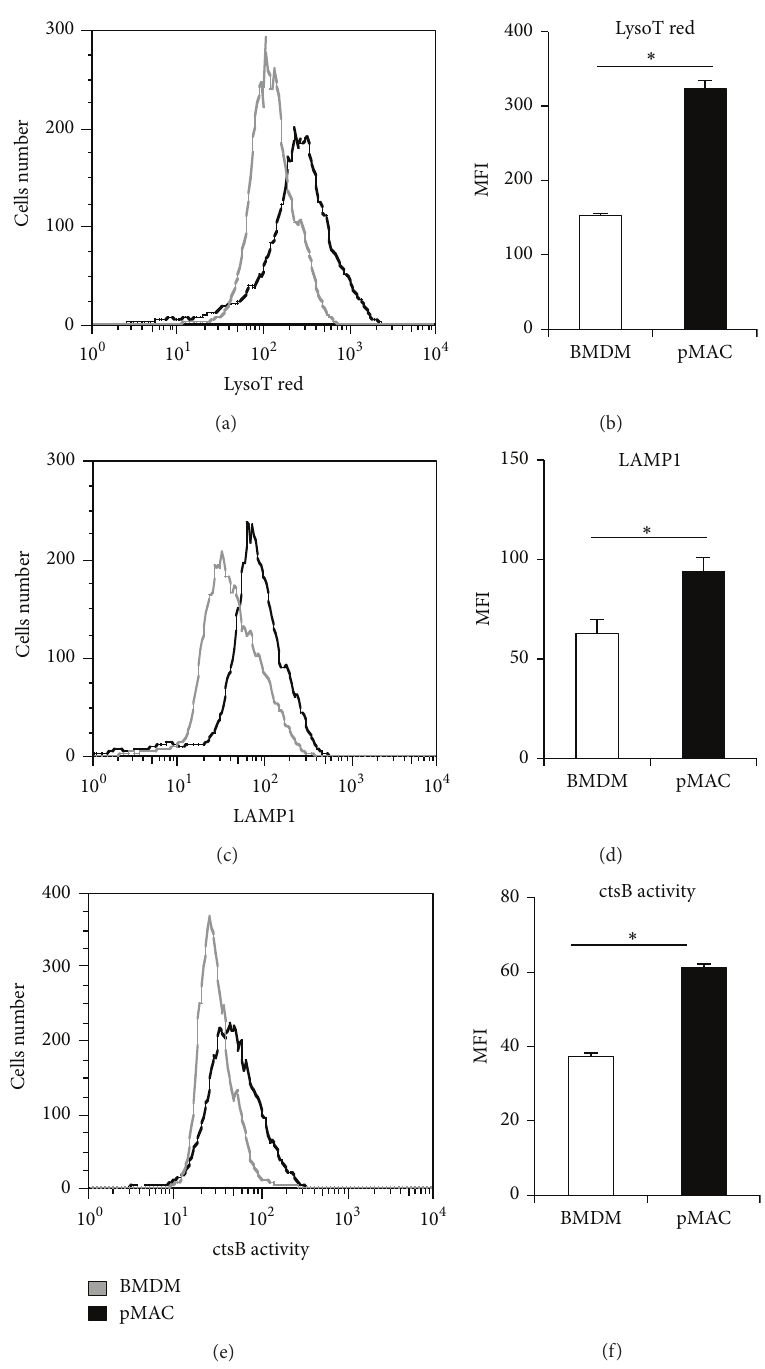
Figure 1: Peritoneal macrophages have increased lysosome volume and activity compared to BMDMs. (a, b) Thioglycollate-elicited peritoneal macrophages (pMACs) or bone marrow-derived macrophages (BMDMs) were stained with lysotracker red and analyzed by flow cytometry. A representative histogram (a) and FL2 mean fluorescence intensity (MFI) quantification (b) are shown. (c, d) Total LAMP1 was determined by staining fixed and permeabilized pMACs or BMDMs with a LAMP1 (CD107a) PE antibody followed by flow cytometry assessment. A representative histogram (c) and MFI quantification (d) are shown. (e, f) Cathepsin B activity was assessed using a fluorogenic cathepsin B substrate that requires cleavage to produce fluorescent signal. After incubation with substrate, pMACs and BMDMs were analyzed by flow cytometry. A representative histogram (e) and MFI quantification (f) are shown. Bar graphs report the mean ± standard error (SE) for a minimum of 3 experiments, each performed in triplicate. ∗ 𝑃 < 0.05 for pMAC versus